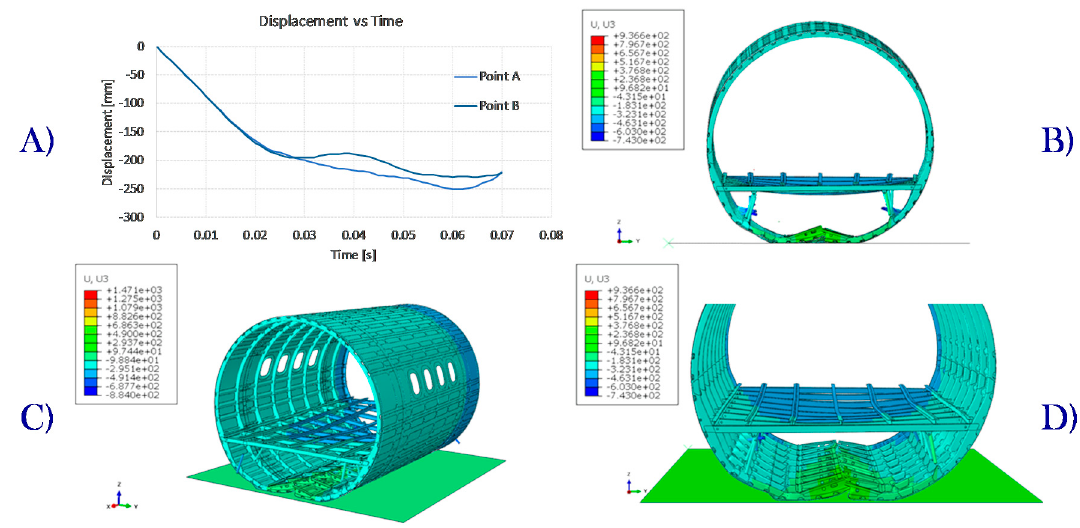
Figure 6. Point displacement